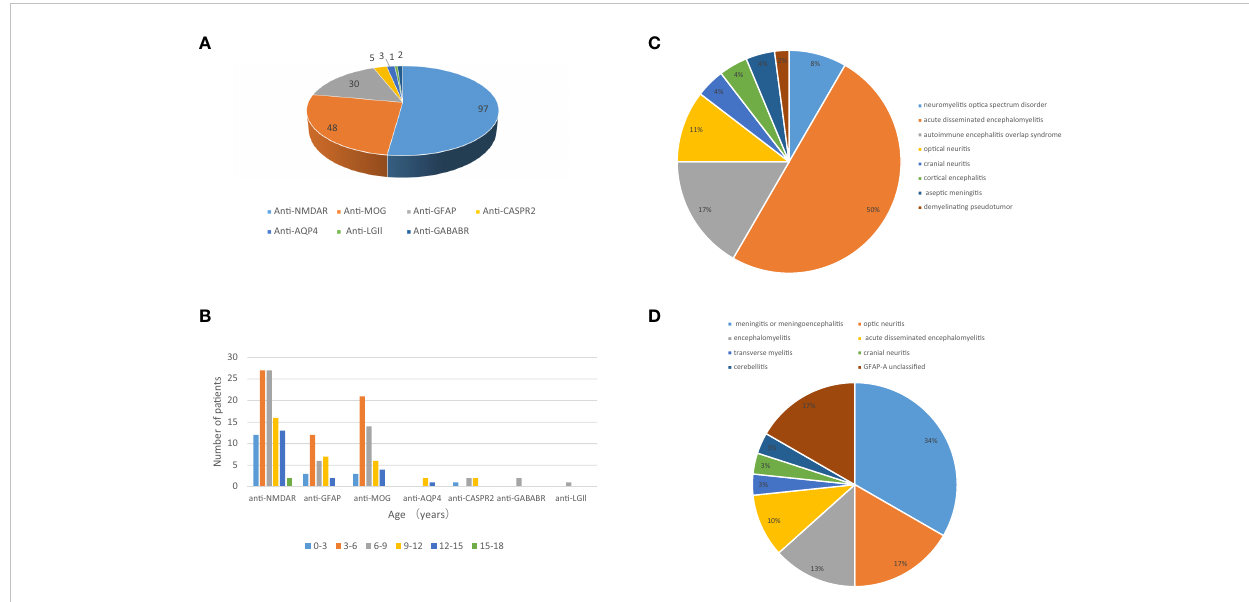
FIGURE 2 The pro fi le of the included patients with antibody-mediated CNS autoimmune diseases. (A) Subtypes of antibody-mediated CNS autoimmune diseases in pediatric patients and (B) age distribution of these patients. The clinical phenotypes of 48 pediatric patients with MOG-AD (C) and 30 pediatric patients with autoimmune GFAP-A (D)